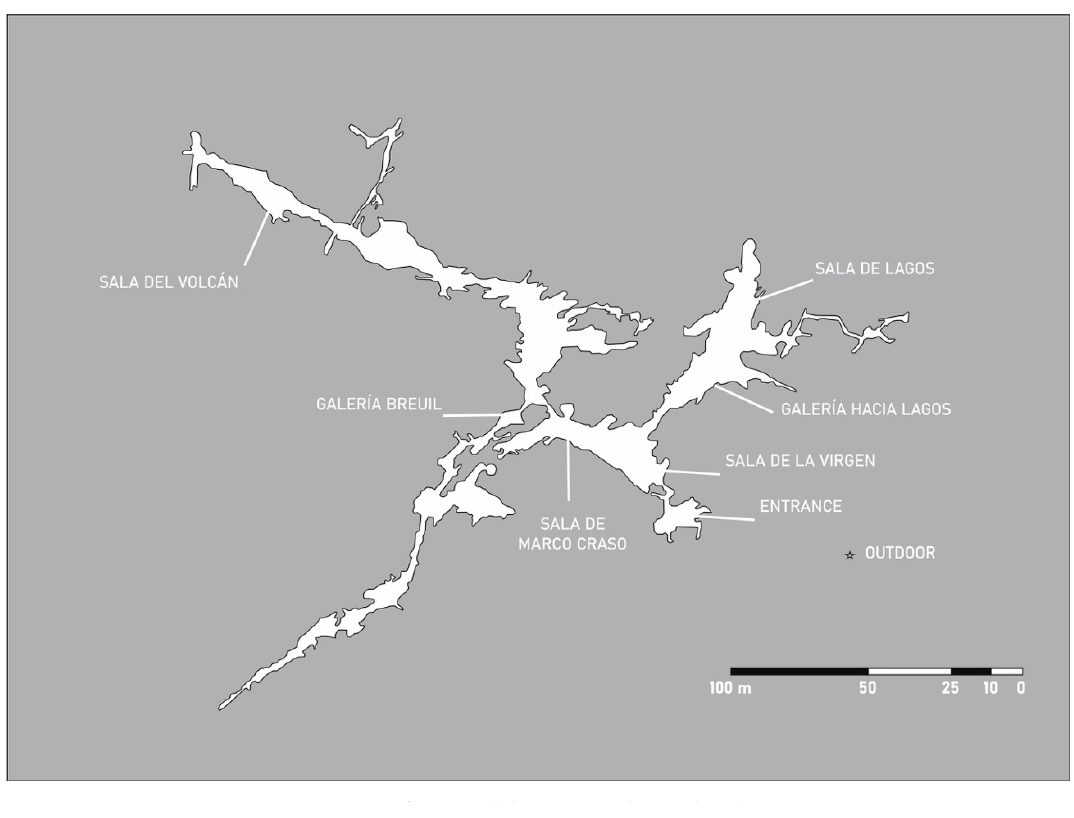
Figure 2. Map of Cueva del Tesoro and sampling locations.